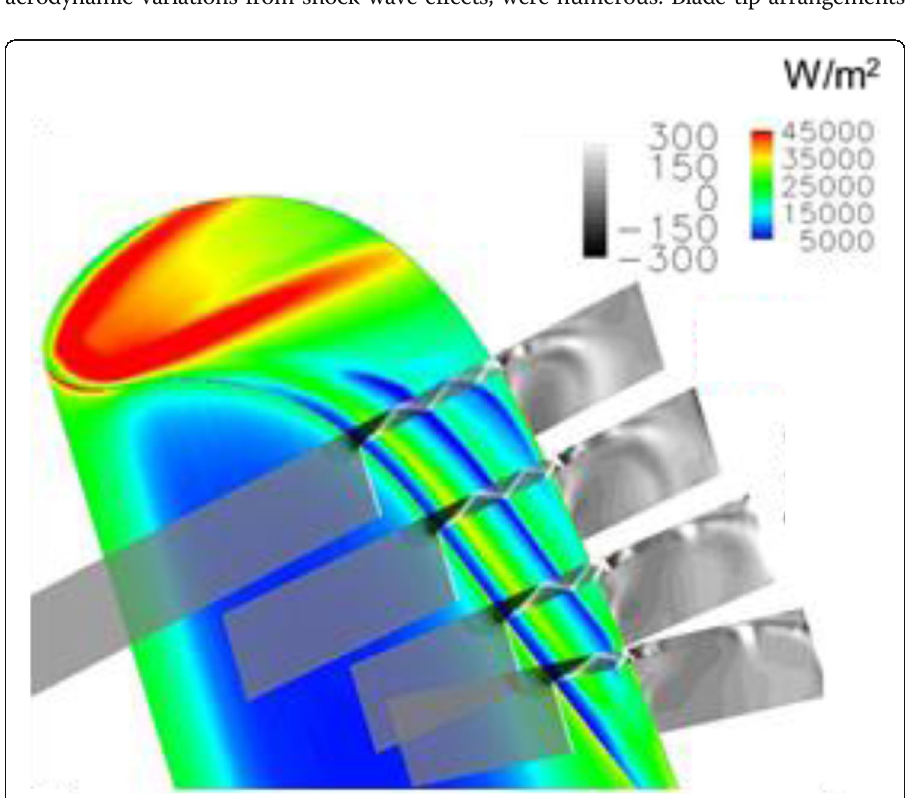
Fig. 6 Transonic tip gap heat transfer and flow characteristics, from Zhang et al. [55], for a flat tip with a 1.5% tip gap. Within the figure, color variations denote tip surface heat flux variations, and greyscale variations denote flow density gradient